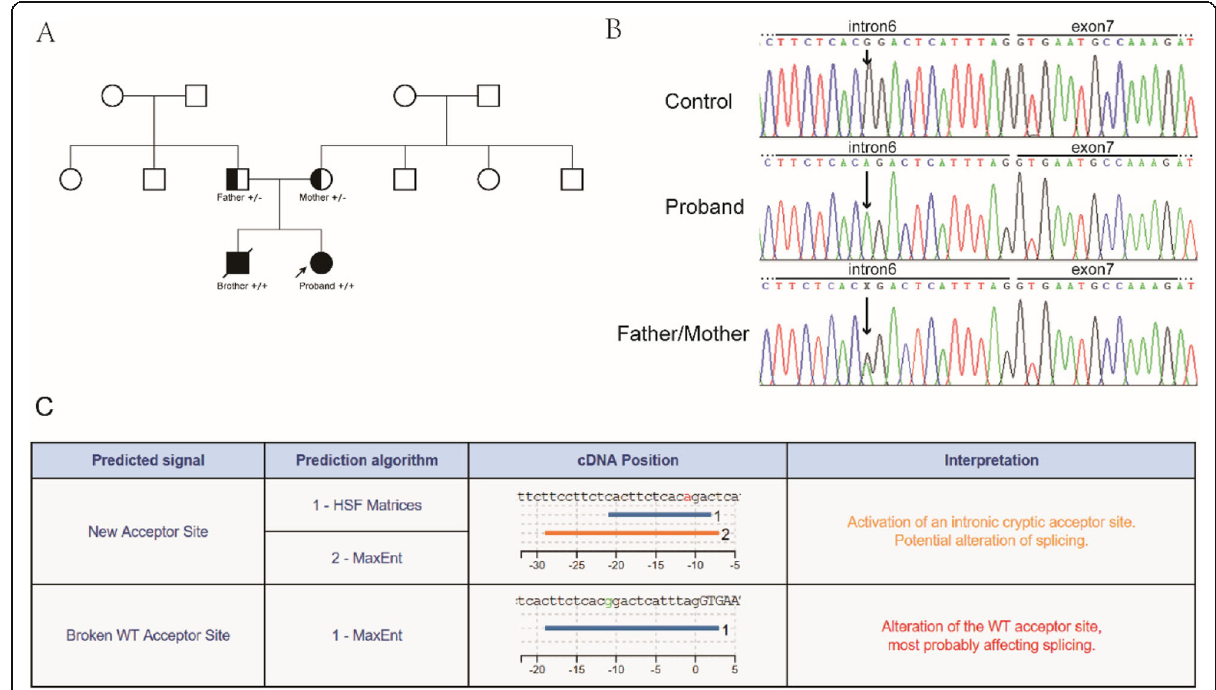
Fig. 1 Identification of F13A1 mutation. A , the family tree. B , Sanger sequences for the proband (homozygote), mother/father (heterozygote), and unaffected control. C , the results of Human Splicing Finder. Both prediction algorithms of the new acceptor site indicate the potential alteration of